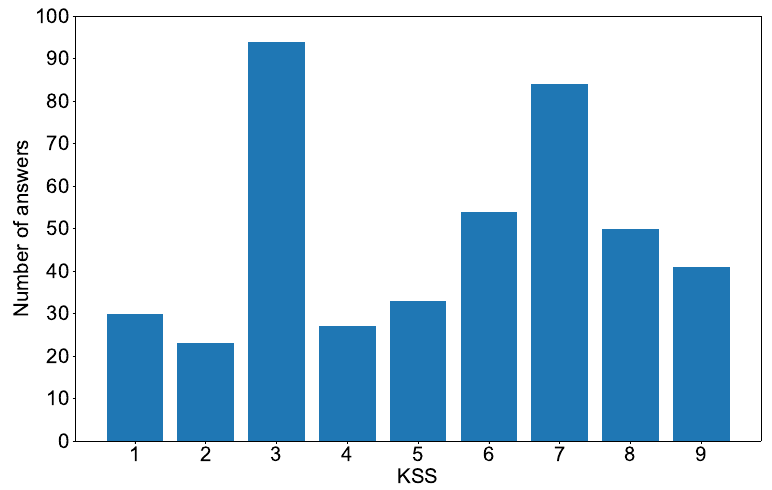
Figure 3. A histogram of Karolinska Sleepiness Scale (KSS) scores and number of answers.